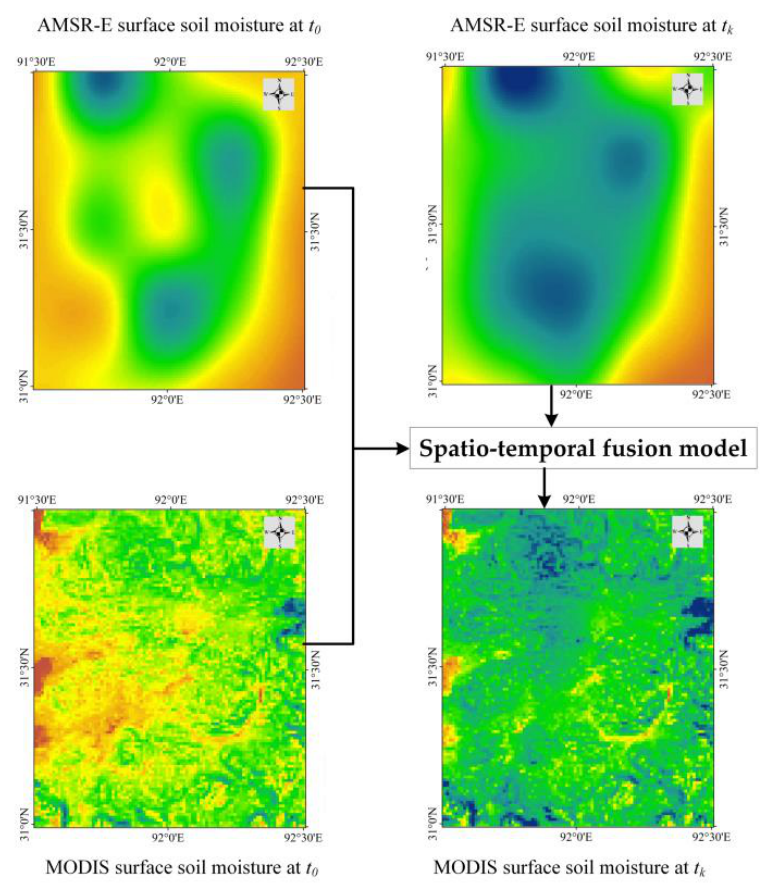
Figure 2. Schematic diagram of surface soil moisture spatio-temporal fusion model.